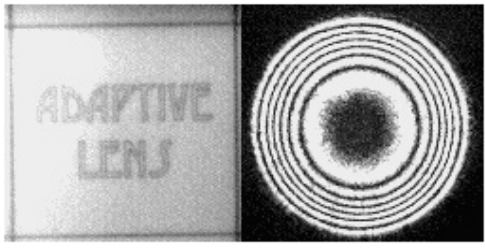
Figure 5. Commercial modal LC lens by Flexible Optical B.V. Reprinted with permission from [118].